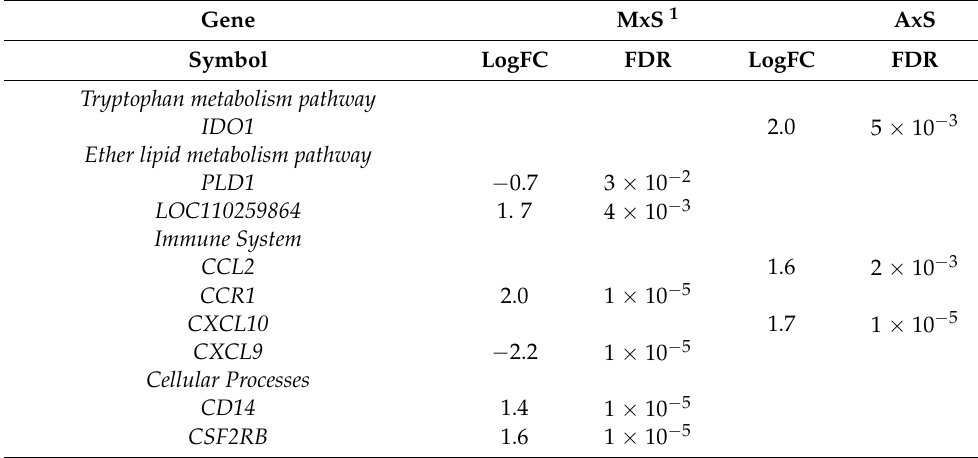
Table 4. Log2(fold change) and False Discovery Rate-adjusted p -value (logFC and FDR, respectively) of genes in the prefrontal cortex that presented a significant (FDR < 0.05) main or interaction effect of sex (S) with morphine (M) and maternal immune activation (A) and represent the pathways enriched at FDR < 0.05 and a normalized enrichment score |NES| > 1.5. Gene MxS 1 AxS Symbol LogFC FDR LogFC FDR Tryptophan metabolism pathway IDO1 2.0 5 × 10 − 3 Ether lipid metabolism pathway PLD1 − 0.7 3 × 10 − 2